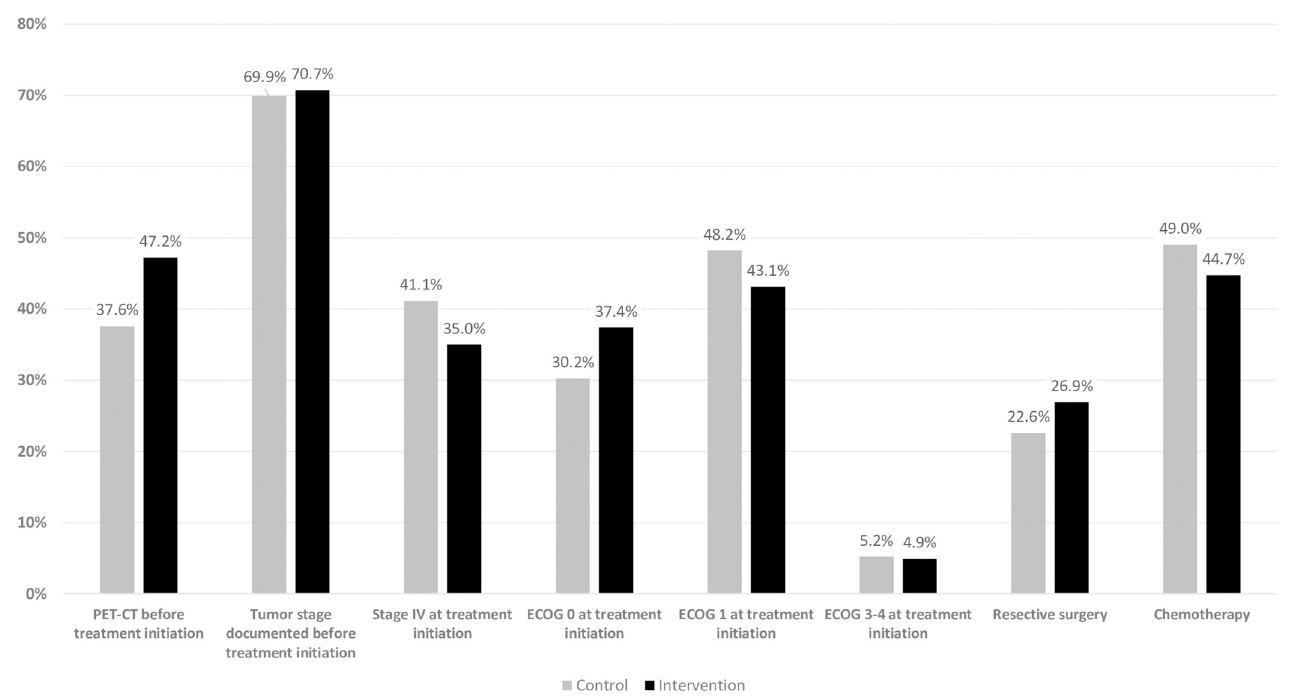
PLOS ONE | https://doi.org/10.1371/journal.pone.0276719 October 25,